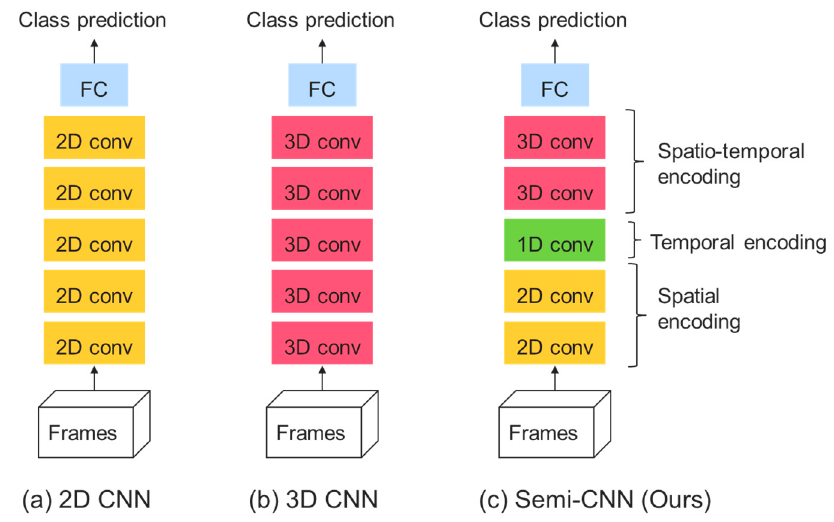
Figure 1. Architecture comparison for ( a ) 2D convolutional neural network (CNN), ( b ) 3D CNN and ( c ) our proposed semi-CNN.